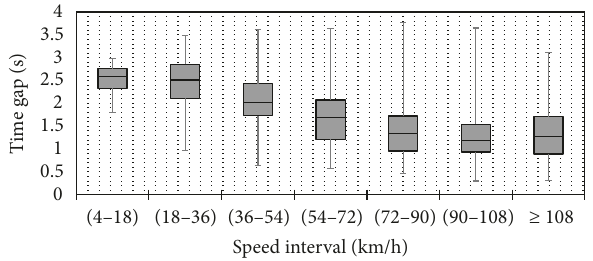
Figure 3: Box and whisker plots for all drivers